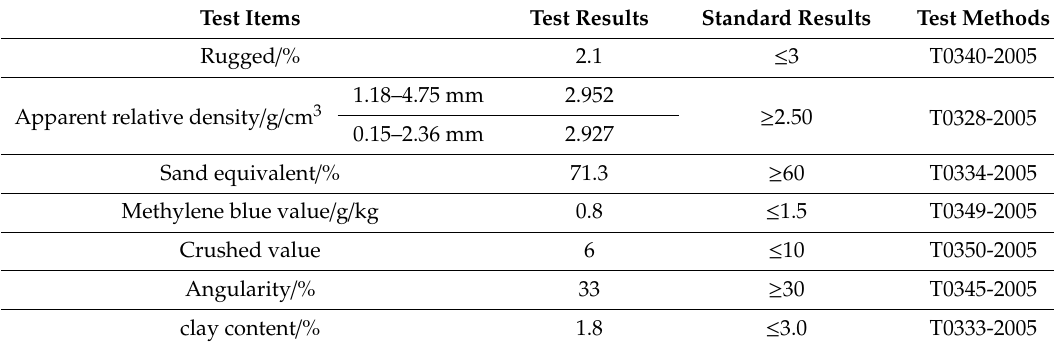
Table 3. Properties of fine aggregate.